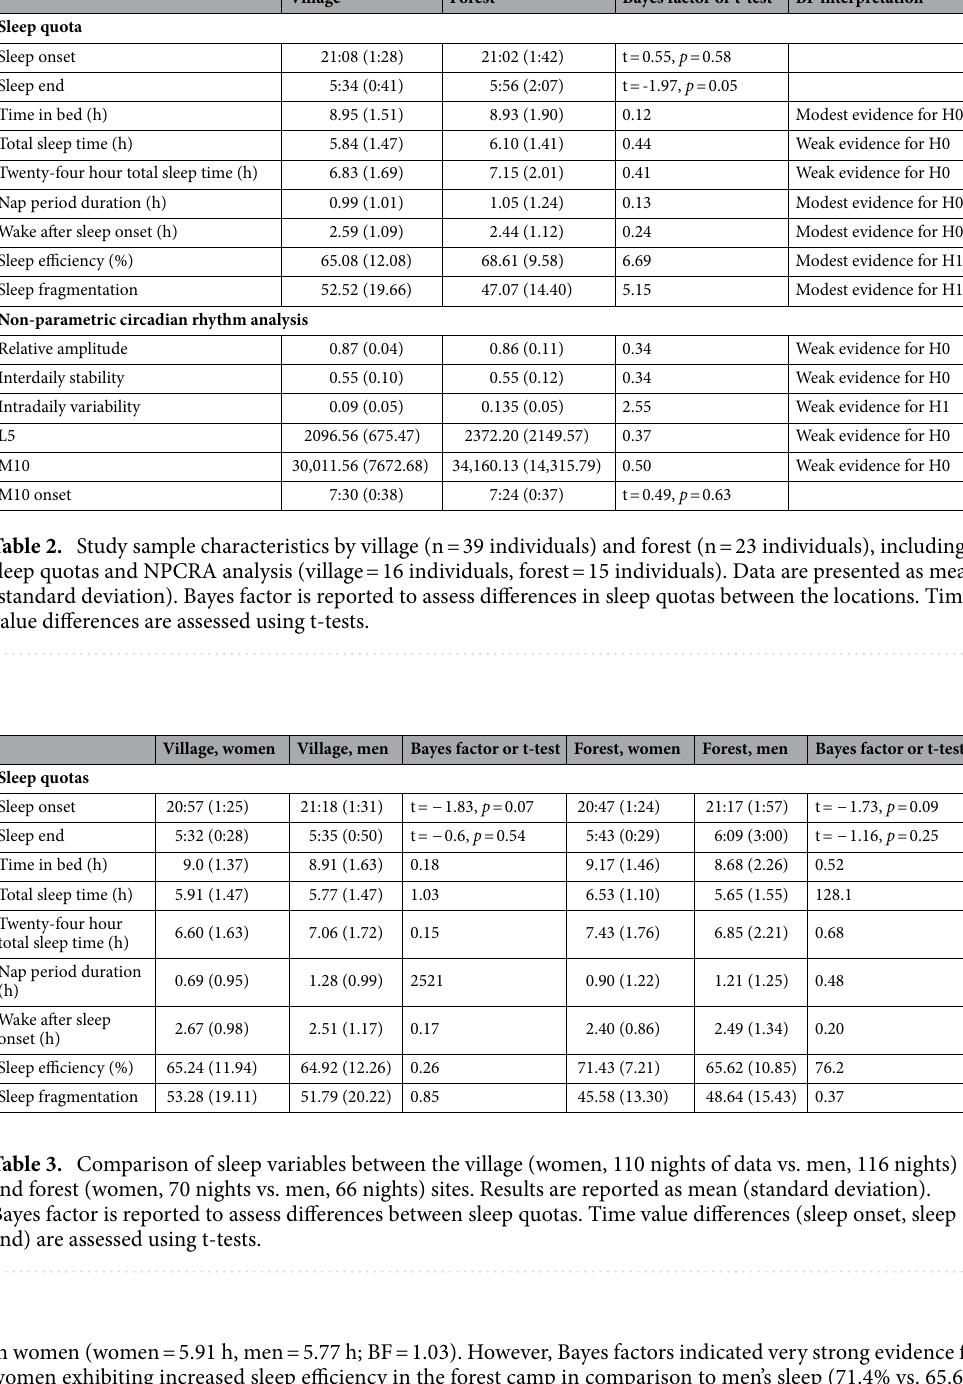
Table 3. Comparison of sleep variables between the village (women, 110 nights of data vs. men, 116 nights) and forest (women, 70 nights vs. men, 66 nights) sites. Results are reported as mean (standard deviation). Bayes factor is reported to assess differences between sleep quotas. Time value differences (sleep onset, sleep end) are assessed using t-tests.